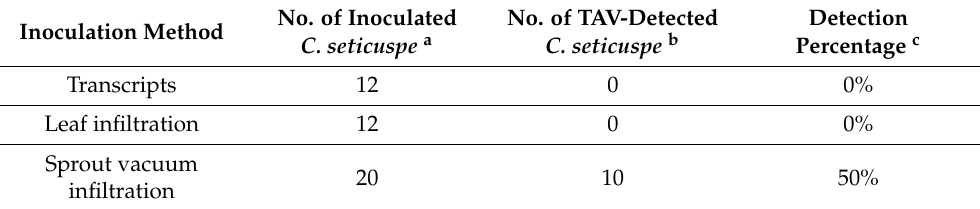
Table 1. Efficiency of different inoculation methods of tomato aspermy virus (TAV) in Chrysanthemum seticuspe .